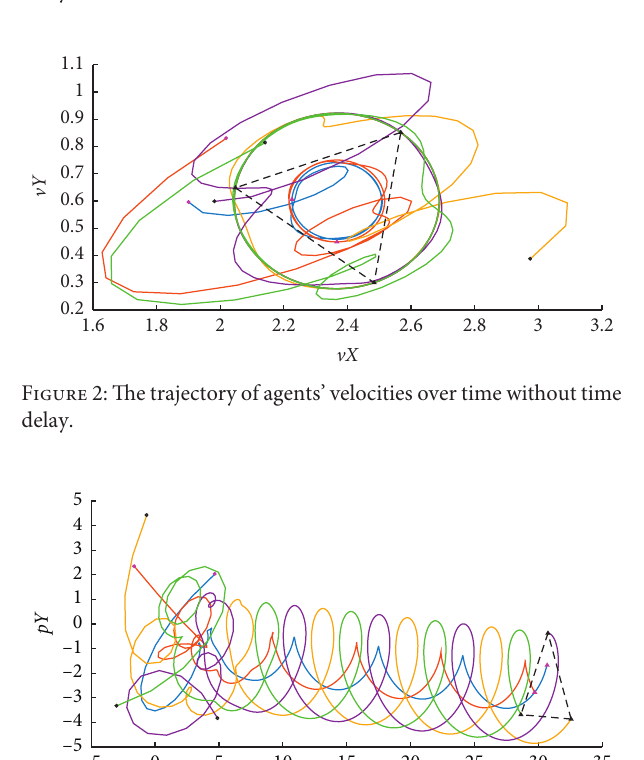
Figure 1: The trajectory of agents’ positions over time without time delay.